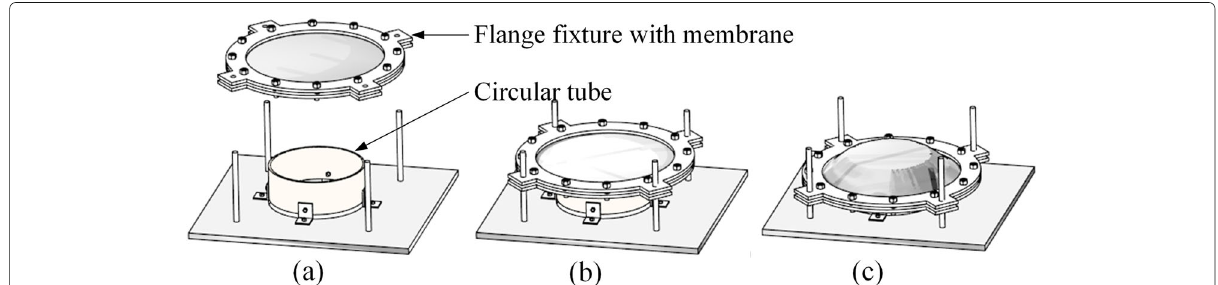
Fig. 8 Tensioning device for experimental modal analysis. a The membrane is held between two flanges. Threaded rods as well as a circular tube are attached two a supporting back panel. The flange fixture is used to hold the membrane at a fixed position. b The starting position, where the membrane barely touches the rim of the tube and does not experience any deformation. c The membrane is stretched over the tube by moving the flange fixture towards the back